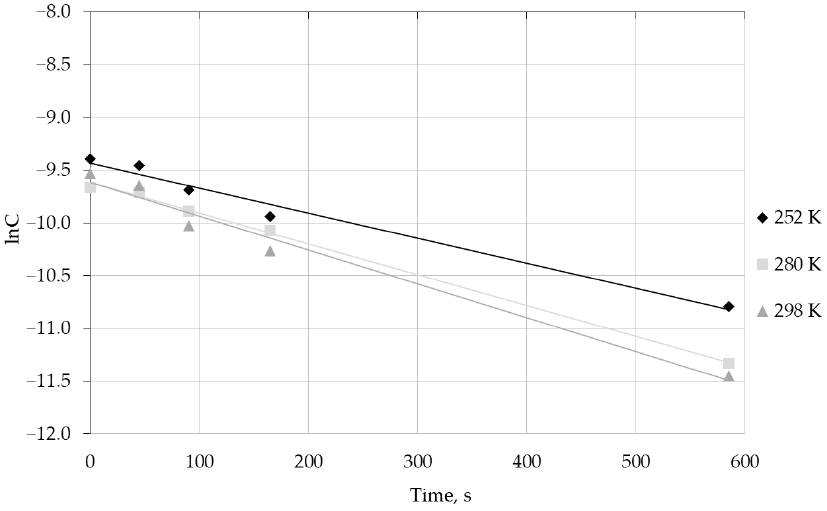
Figure 3. The dependence of the H 2 S concentration change on the time of sorption on ferromanganese material at different temperatures.